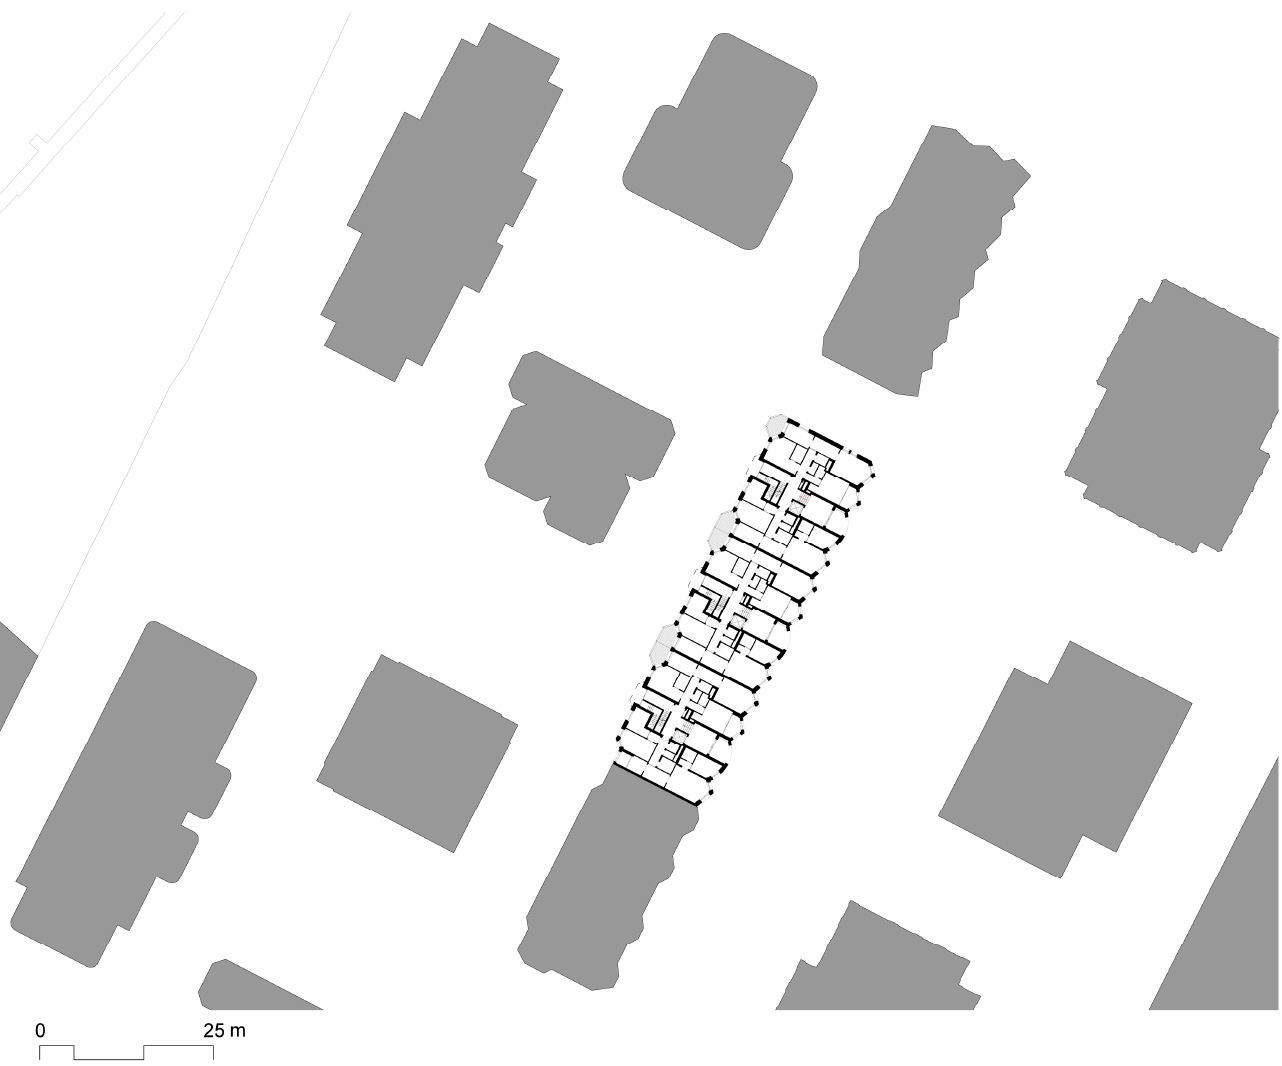
Figure 9. Urban layout of the project “Tour and Taxis” by Sergison Bates architects (re-drawing by the authors).